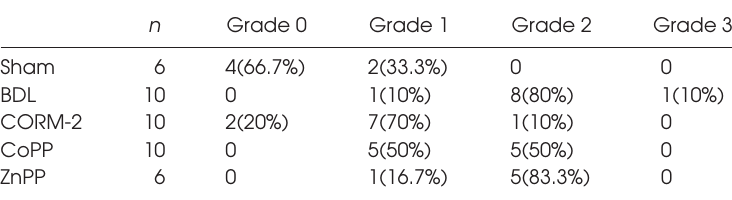
Table 1. Pathological grading of liver fibrosis in SD rats.